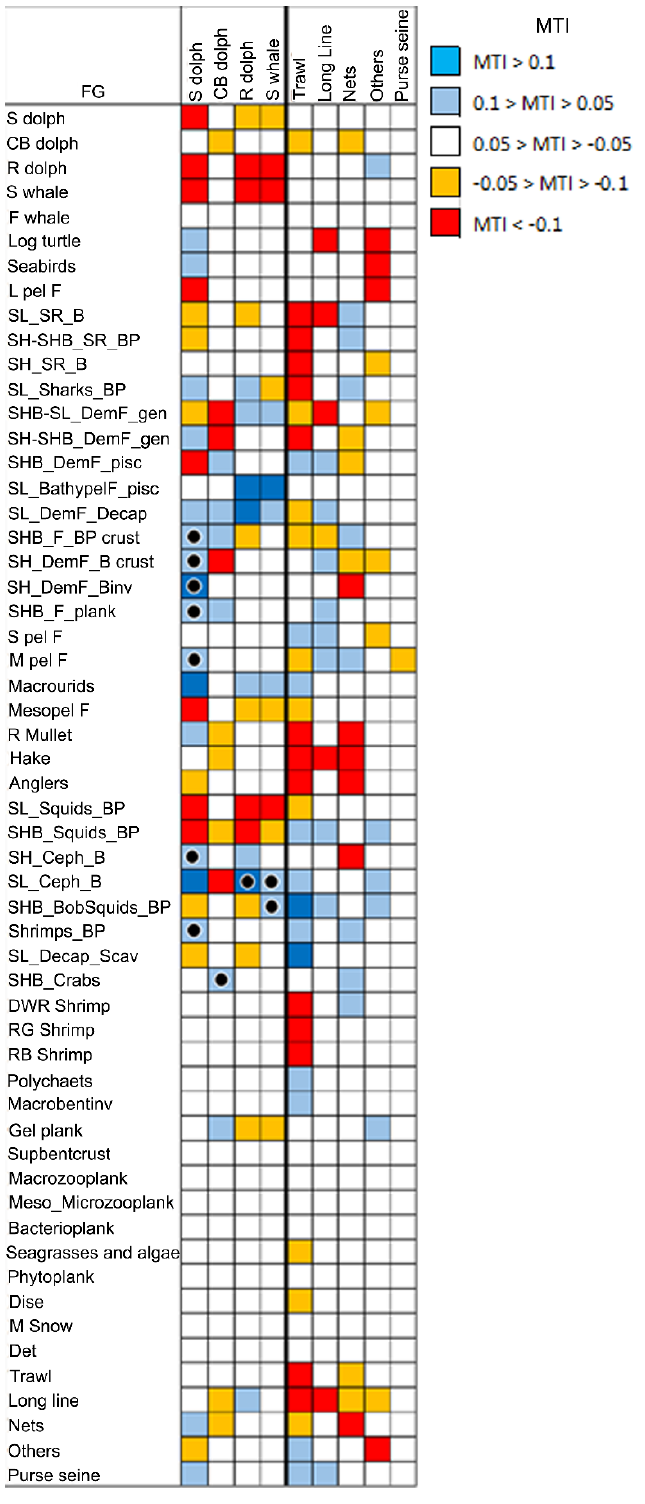
Figure 3. Mixed trophic impacts by odontocetes and fisheries estimated for all FGs and fishing gear during the period 2010–2014. The numbers at the head of the columns indicate the odontocete species and the fishing gear impacting on the FGs of the GoT food web. The black circle indicates the condition of beneficial predator (positive impact on a prey). FG codes are reported in Table 2.